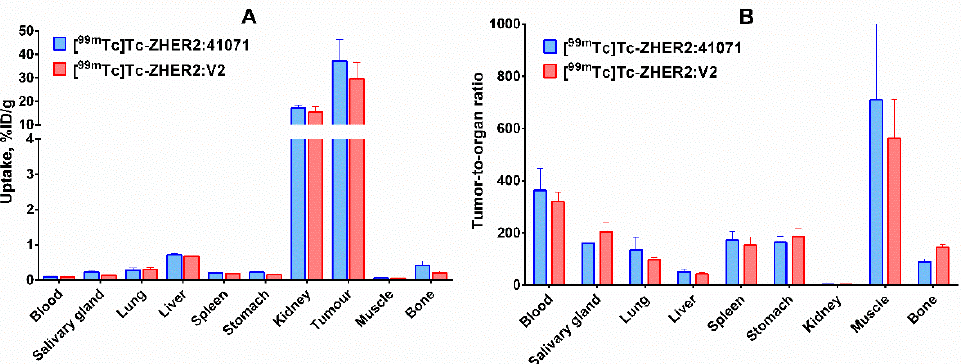
Figure 9. ( A ) Biodistribution and ( B ) tumor-to-organ ratios of selected conjugates, [ 99m Tc]Tc-ZHER2:41071 and [ 99m Tc]Tc-ZHER2:V2, in BALB/C nu/nu mice bearing HER2-expressing SKOV3 xenografts 4 h after injection. The data are presented as the average value ( n = 4) and SD. Results of microSPECT/CT imaging (Figure 10) demonstrated that a high-contrast visualization of HER2 expression in HER2-positive tumor using [ 99m Tc]Tc-ZHER2:41071 is feasible. The SKOV3 tumor on right hind leg was clear and, with a high contrast, visualized at 4 h after injection. In agreement with the biodistribution data, the radioactivity uptake in the tumor was considerably higher than in the kidney. Activity uptake in HER2-negative Ramos xenografts was apparently much lower than in the SKOV-3 xenograft.